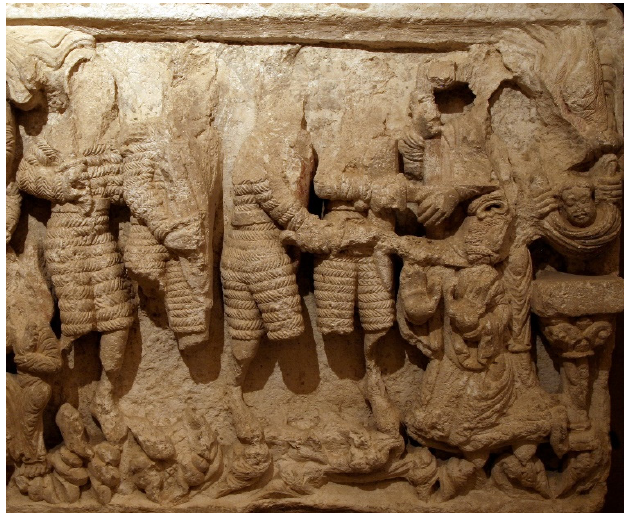
Figure 2. Almazán. Frontal (detail). Murder of Thomas